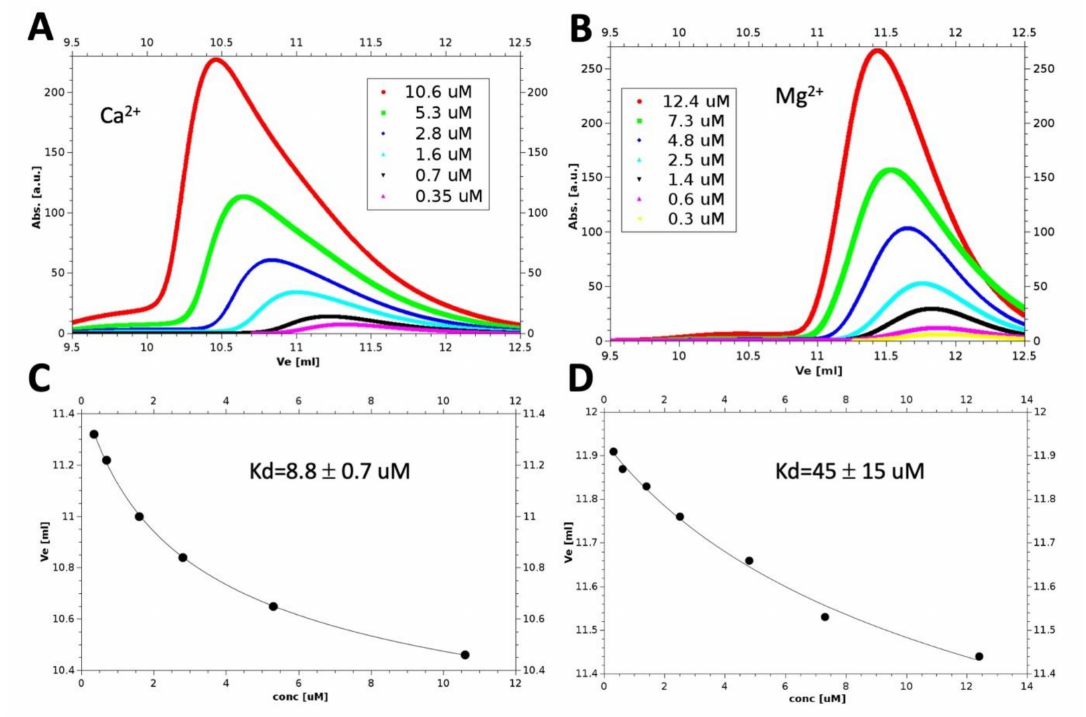
Figure 1. Dissociation constants calculated from size exclusion chromatography (SEC) experiments. SEC experiments in presence of Ca 2 + ( A ) or Mg 2 + ( B ) at di ff erent protein concentrations. In the lower panels ( C , D ) are reported the corresponding variations of elution volumes (Ve) with protein concentration (black dots) together with the 3-parameters theoretical curves fitting the experimental data (black